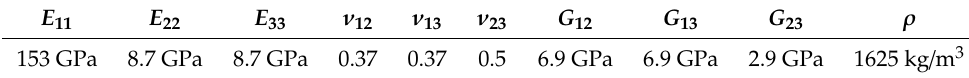
Table 2. Engineering constants of the unidirectional prepreg.